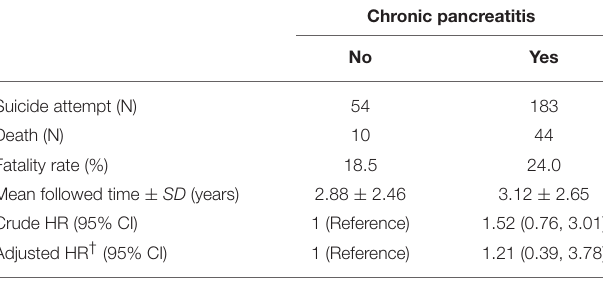
TABLE 6 | Suicide-related fatality (completed suicide) of patients with chronic pancreatitis compared with those without chronic